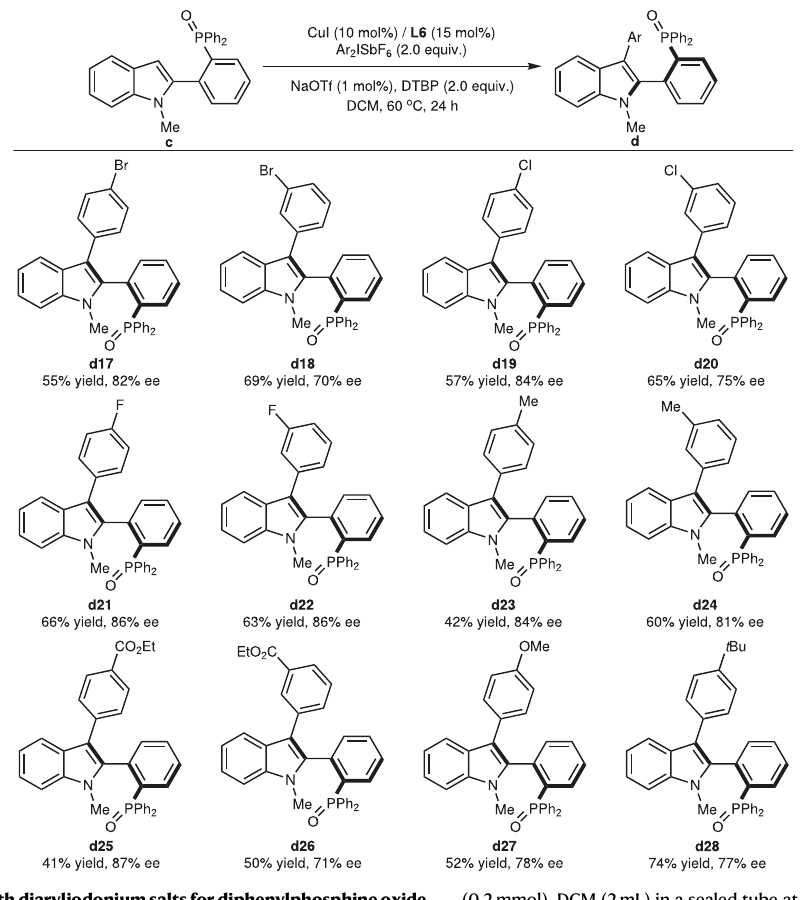
(0.2mmol), DCM (2mL) in a sealed tube at 60°C for 24h. DTBP 2,6-di- tert - butylpyridine.